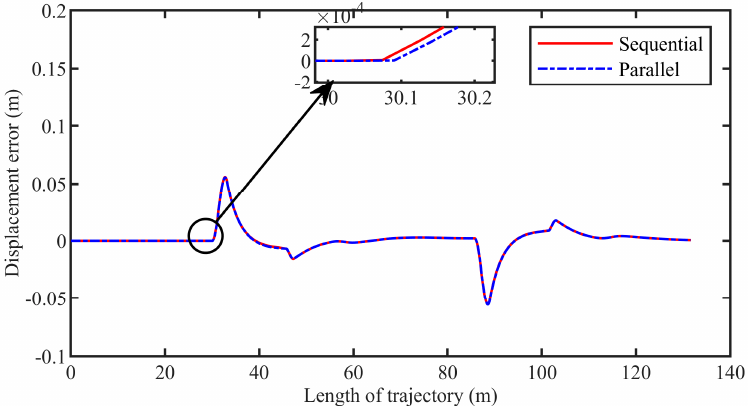
Figure 15. Displacement error of the comparison between calculation processes.